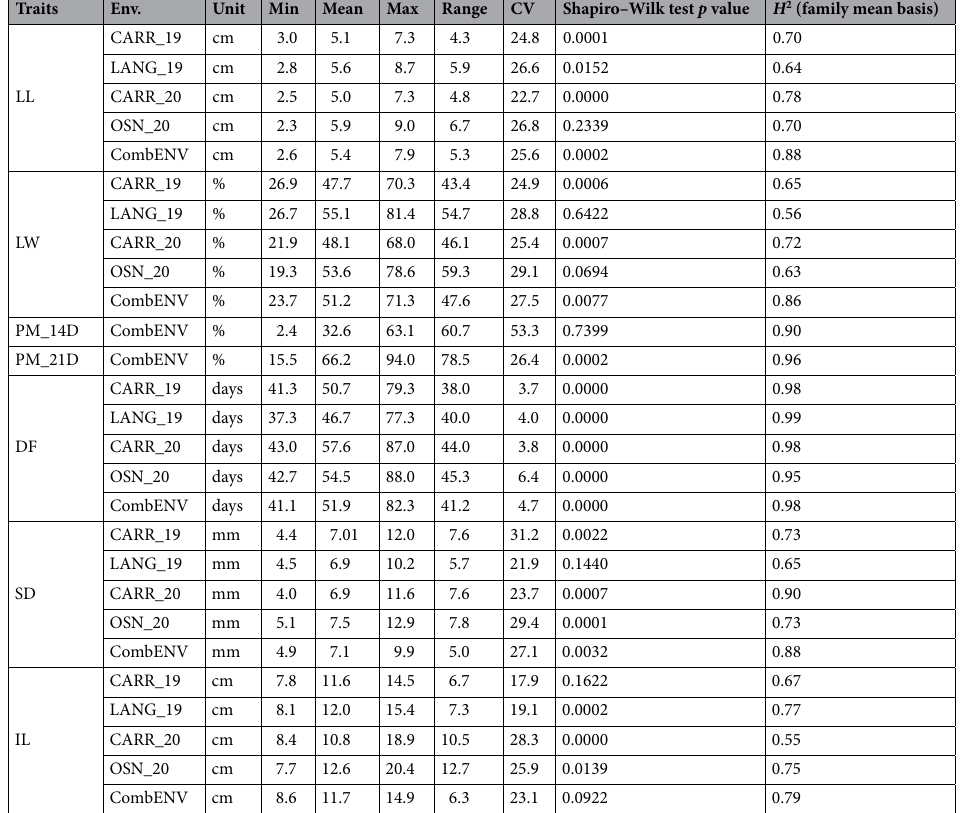
Table 1. Phenotypic variation obtained through BLUEs in the response of 187 Brassica napus genotypes sclerotinia stem rot. LL lesion length measured 7 days post inoculation (dpi), LW lesion width measured 7 dpi, Env environments, Carrington 2019 (CARR_19) and 2020 (CARR_20), Langdon 2019 (LANG_19), Osnabrock 2020 (OSN_20), combined across all environments (CombENV), Min minimum, Max maximum value, CV coefficient of variation, Shapiro–Wilk test test for